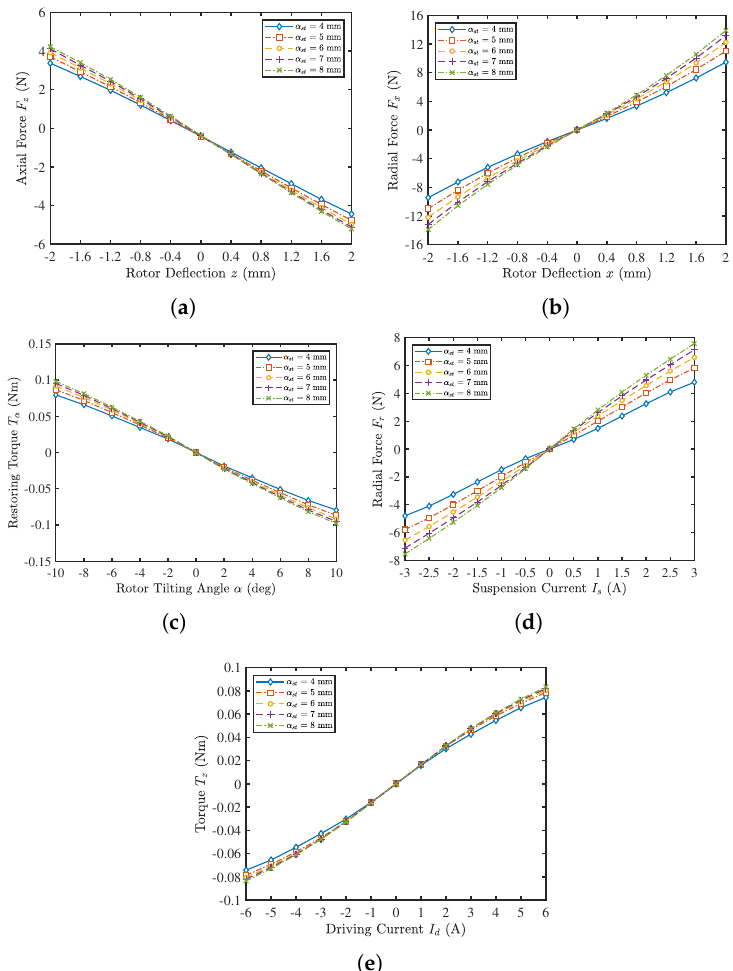
Figure 12. Three-dimensional FEM simulation results for different stator tooth widths α st . ( a ) Axial reluctance force for a rotor deflection in the z -direction. ( b ) Radial destabilizing force for a rotor deflection in the x -direction. ( c ) Restoring torque for a rotor tilting around the axis perpendicular to the direction of magnetization. ( d ) Active radial force for an applied suspension current. ( e ) Active torque for an applied drive current.